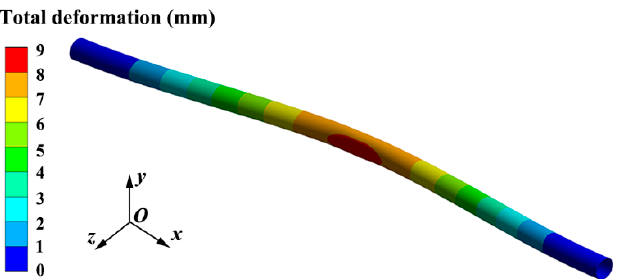
Figure 8. Pipe total deformation at 0.01 s with liquid hydrogen inside the pipe.